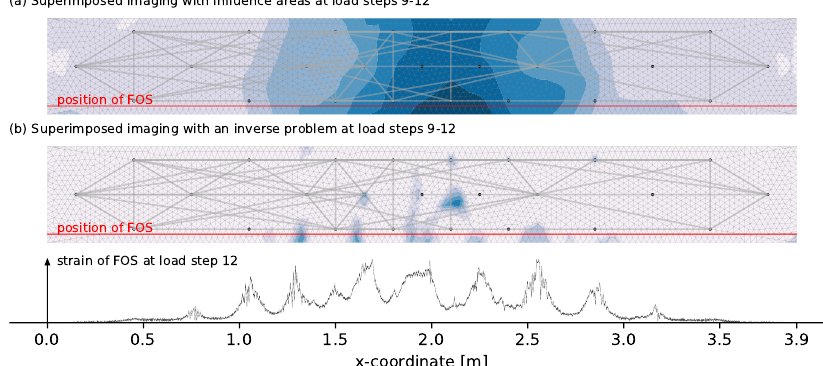
Figure 10. Evaluation of the change between load step 8 and 12 with the two different methods of imaging from Sections 2.4 and 2.5 shown in ( a , b